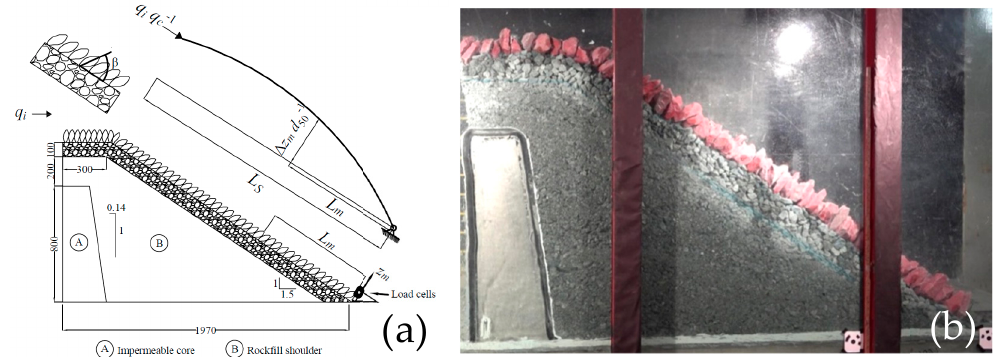
Figure 7. ( a ) Depiction of experimental setup of half dam model with core and placed riprap supported at the toe and ( b ) image of the model built in the flume.